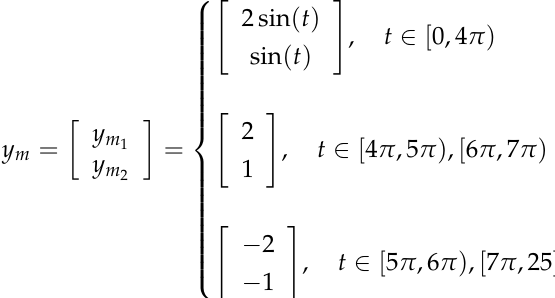
and ( b ) y 2 , y m 2 1